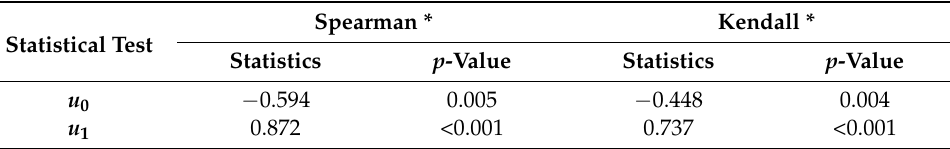
Table 6. Results of statistical test for Hypothesis 4.